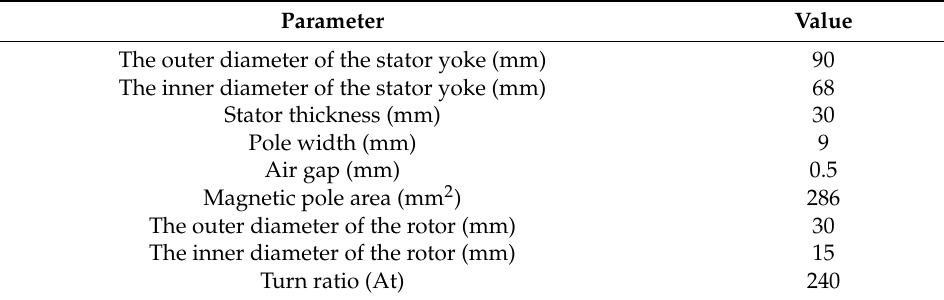
Table 1. Structural parameters of the 8-pole